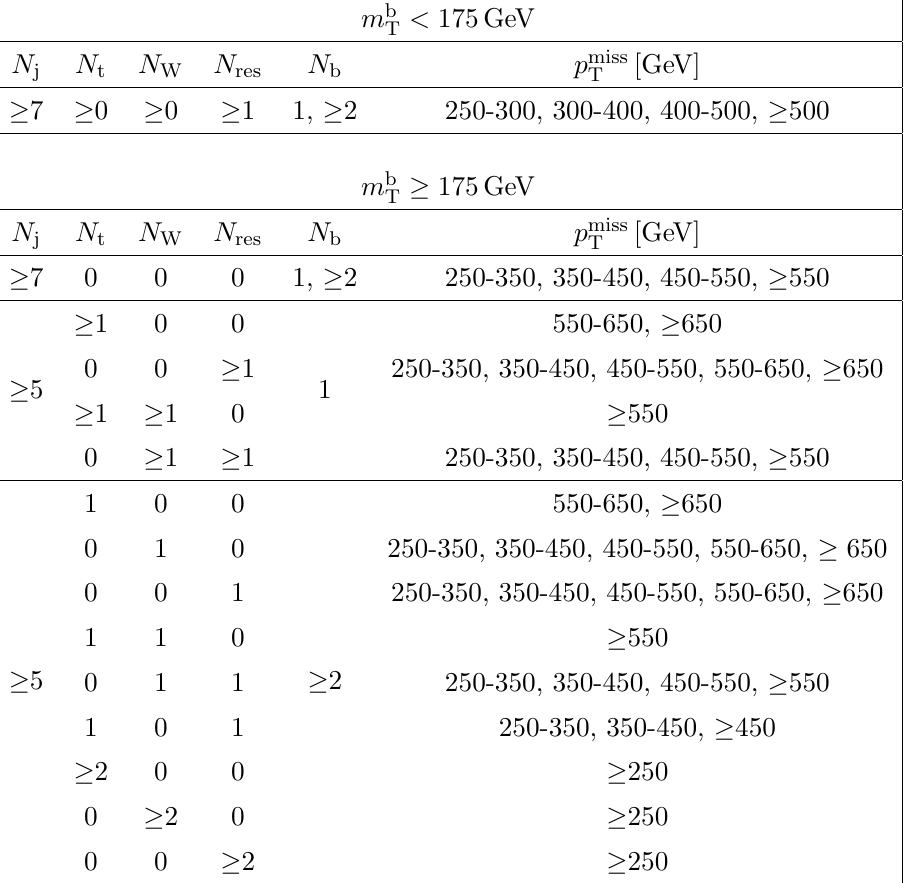
(cid:21) 250 GeV, no leptons, N T